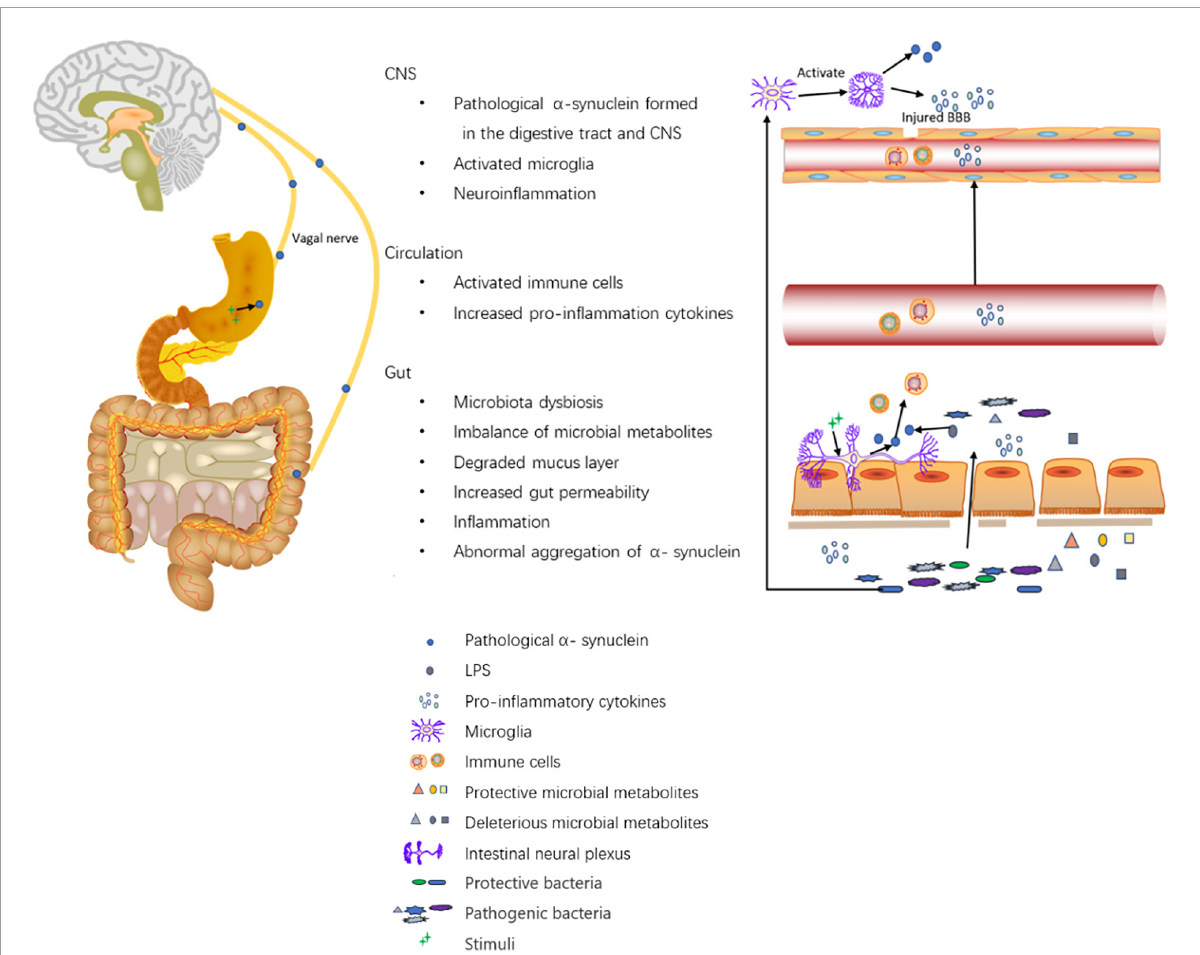
FIGURE1 Roles of the digestive tract in the pathogenesis of PD. The altered composition of gut microbiota leads to altered levels of microbial metabolites such as SCFAs, vitamins, hydrogen sulfide, LPS, amino acid, and TMAO. First, on the one hand, SCFAs modulate gut barrier protection via HIF and modulate inflammation by inhibiting NF-kappaB activation; on the other hand, SCFAs alone may activate microglia and induce increased α -synuclein aggregation in the brain. Second, hydrogen sulfide has a protective effect on dopaminergic neurons. Third, LPS promotes intestinal α -synuclein aggregation. Forth, the imbalance of microbial metabolites can cause increased gut permeability and increased levels of inflammatory cytokines like TNF- α , IF- γ , IL-6, IL-1 β , calprotectin, and NGAL. Moreover, Akkermansia can degrade the mucus layer of the gut. Then, the increased gut permeability exposes intestinal neural plexus to stimuli such as oxidative stress, pesticide/herbicide, traversed gut microbiota, and microbial metabolites, causing abnormal aggregation of α -synuclein fibrils in the intestine and inducing inflammation. Pathological α -synuclein promotes the activation of Th1 and Th17 in the circulation (accompanied by elevated levels of IL-6, TNF- α , IFN- γ , IL-1 β , IL-2, IL-10, C-reactive protein, and RANTES), which activate microglia in the CNS through damaged BBB. Furthermore, gut microbiota dysbiosis can also activate microglia in the CNS. The activated microglia promote the aggregation of α -synuclein and releases reactive oxygen, nitrogen species, and pro-inflammatory cytokines to induce neuroinflammation. Additionally, Intra-gastric stimulation causes the formation of pathological α -synuclein within ENS, and the α -synuclein can directly be transmitted to the brain via the vagal